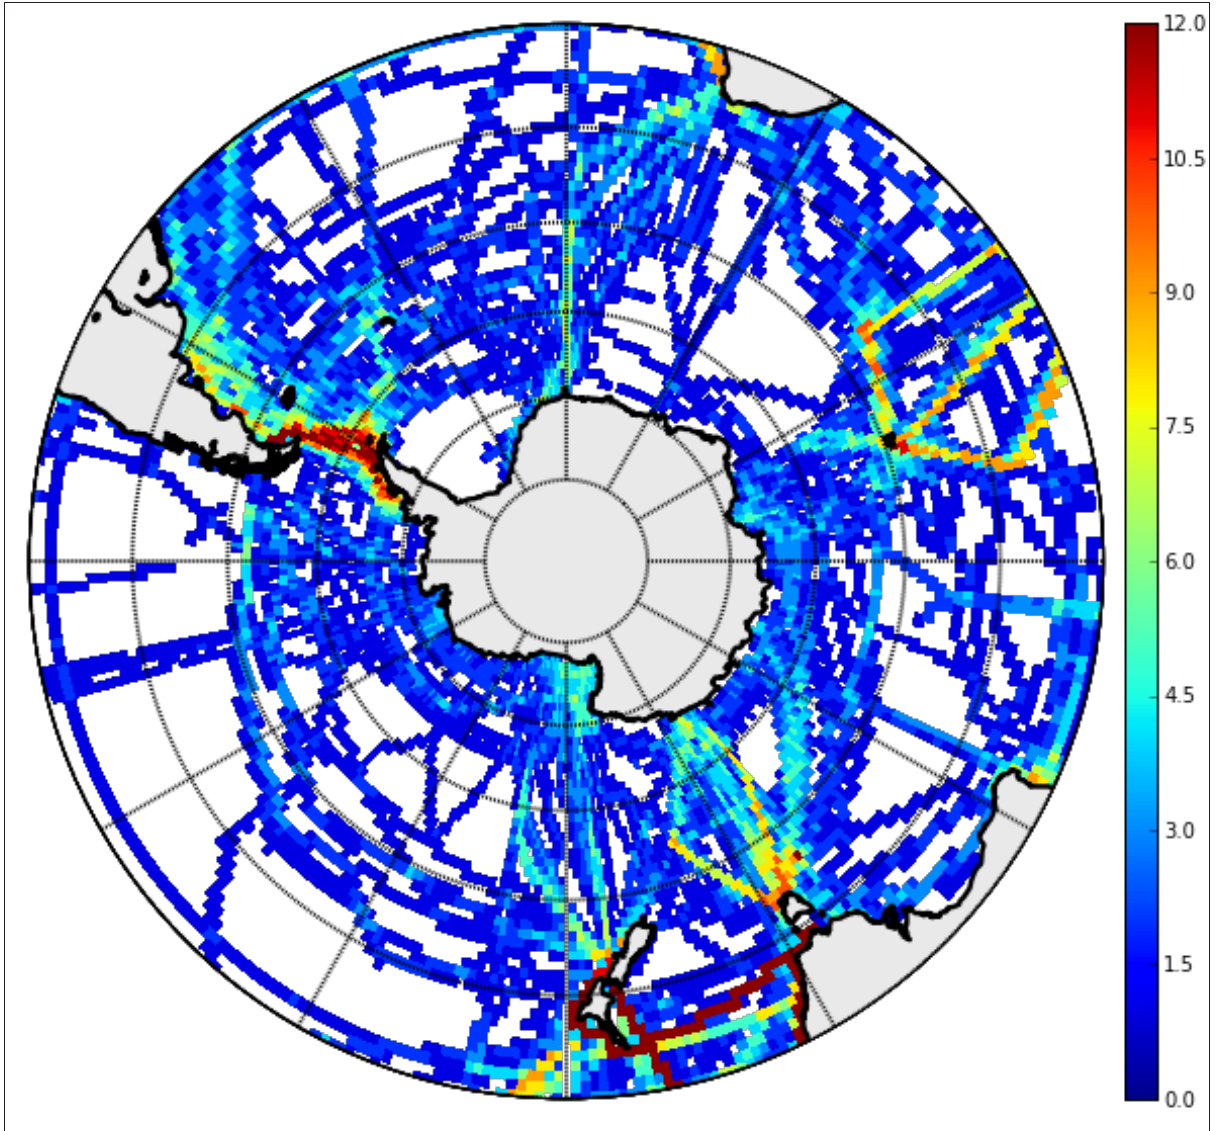
Atlas (SOCAT v3). The annual occupation 2